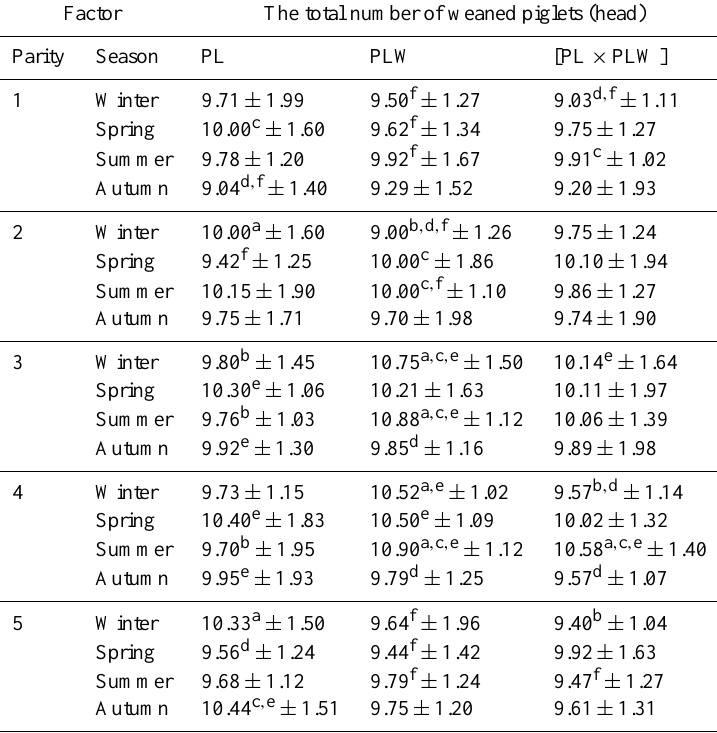
Table 3. The impact of season, parity and breed on the total number of weaned piglets. Factor The total number of weaned piglets